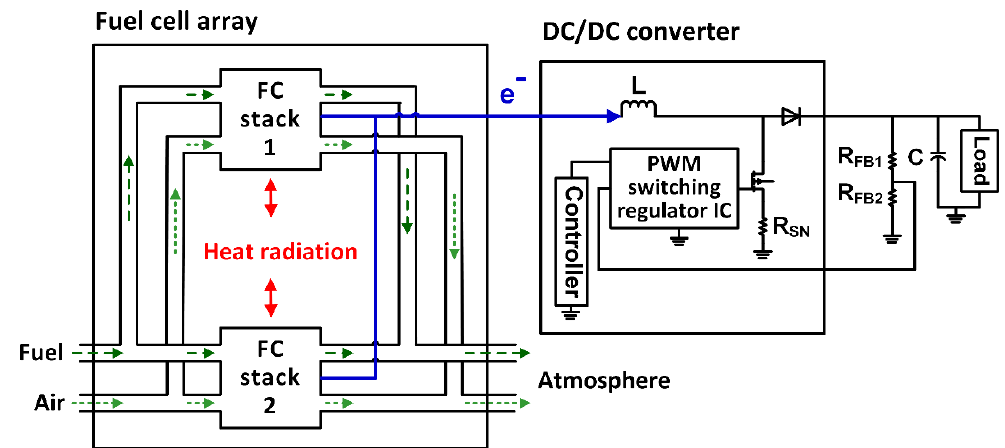
Figure 1. Schematic of the two fuel-cell (FC) stacks connected in parallel. The stack system is followed by a DC–DC converter to deliver power to the load. The green arrows represent the fuel supplying and exiting the stacks; the blue arrows represent electricity output; the red arrows represent the heat exchange between stacks.